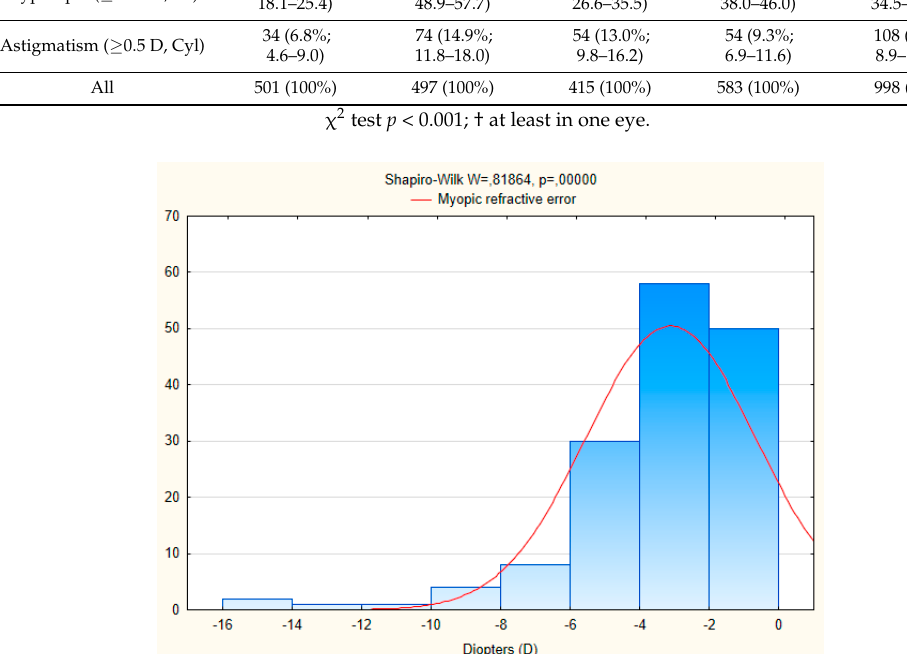
Figure 1. Histogram of myopic refractive error in the researched population.